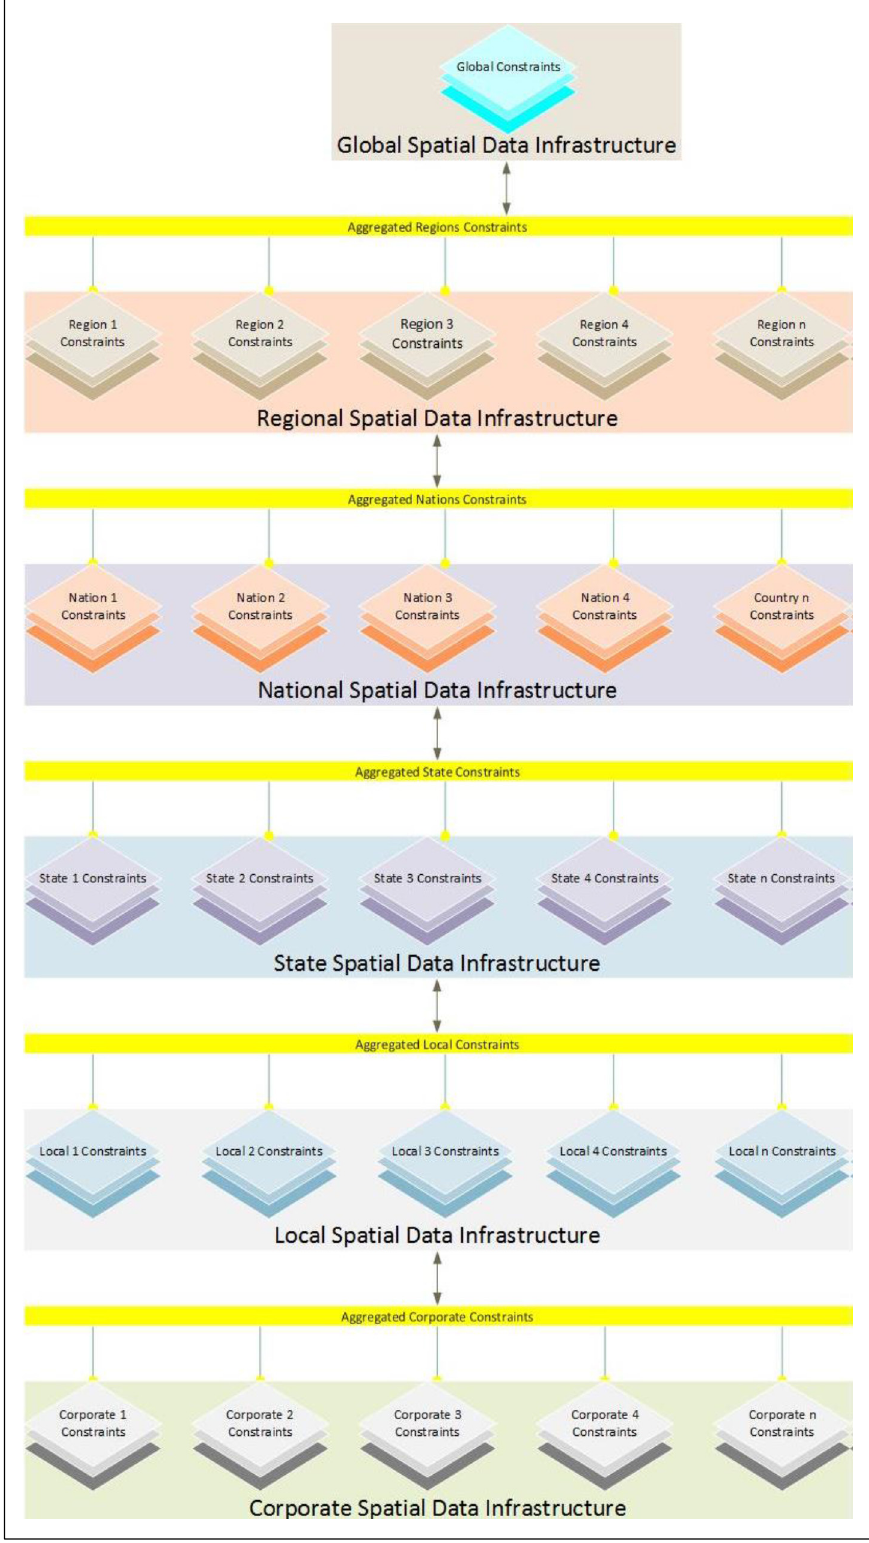
Figure 1. SDI hierarchy constraint modelling (source: [5]).